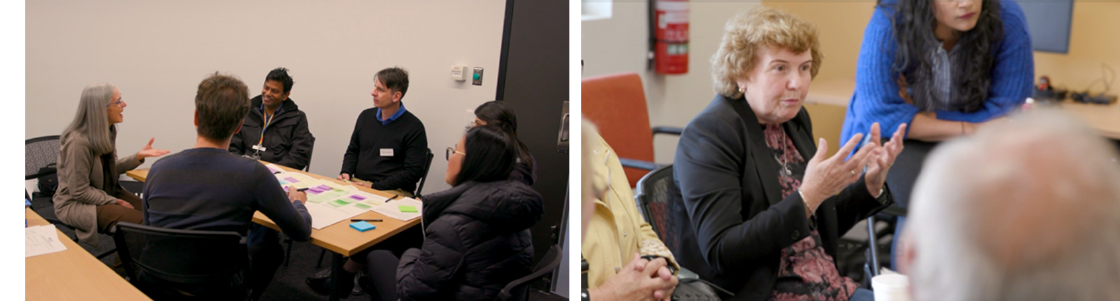
Figure 10. Council staff and older adults contributing to the conversation and agenda